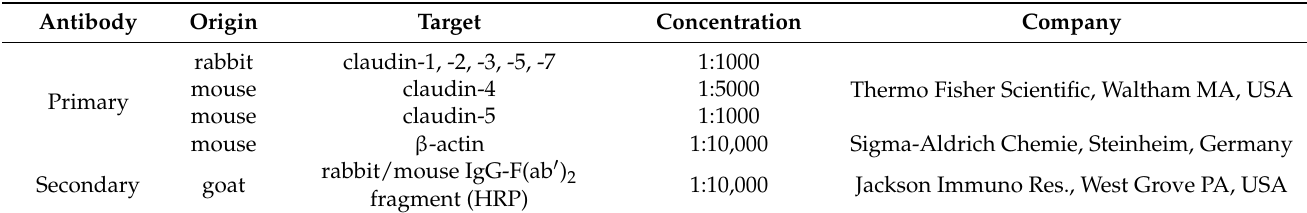
Table 5. Primary and secondary